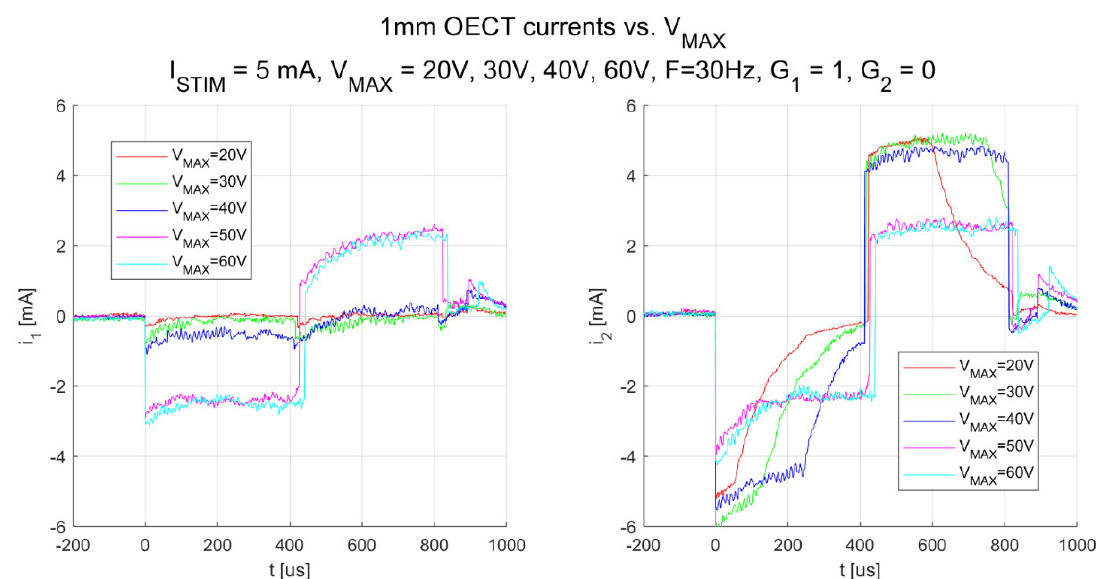
Figure 9. Effects of maximal output voltage of the stimulation system, ranging from 20 V to 60 V, on the switching capabilities of the OECT architecture with a 1 mm channel at a 5-mA stimulation current. The current was measured in both parallel branches of the OECT characterization testbed, with the non-conductive branch shown in the left panel and conductive branch shown in the right